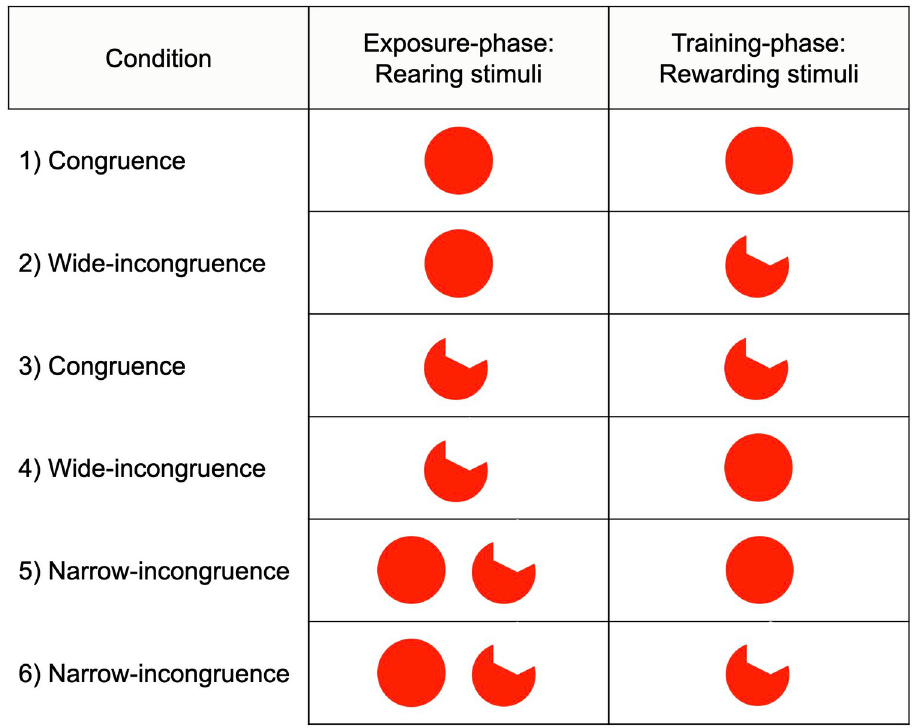
Fig 3. Overview of Experiment 1. Six experimental conditions were arranged: Reared full red disk-rewarded full red disk (“congruence”); reared full red disk-rewarded amputated red disk (“wide-incongruence”); reared amputated red disk-rewarded amputated red disk (“congruence”); reared amputated red disk-rewarded full red disk (“wide- incongruence”); reared mixed-rewarded full red disk (“narrow-incongruence”); reared mixed-rewarded amputated red disk (“narrow-incongruence”). The two narrow-incongruence conditions relate to the original experimental design by Bateson and Chantrey (1972).